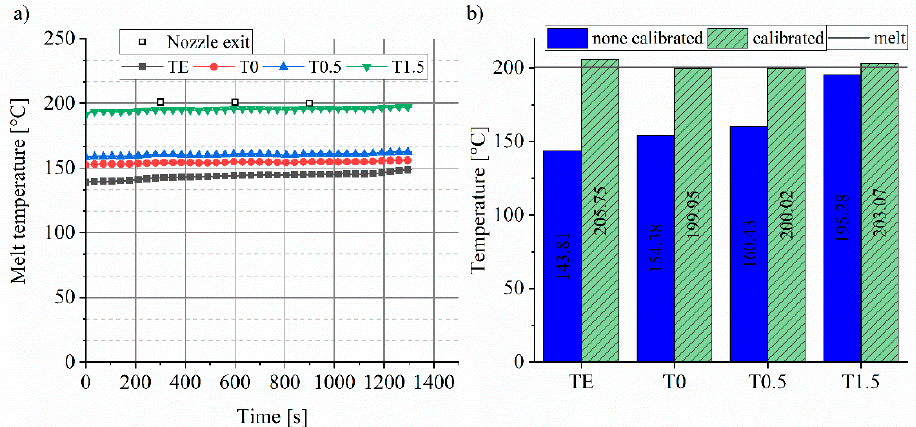
Figure 15. ( a ) Monitor conditioning of the melt temperature and ( b ) influence of the calibration on the measured mass temperature.